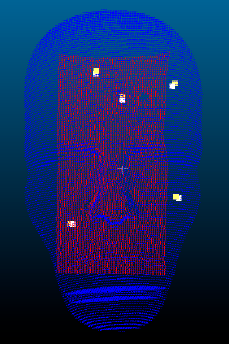
Figure 13. Alignment result of using I-ICP on Dummy Head #1.